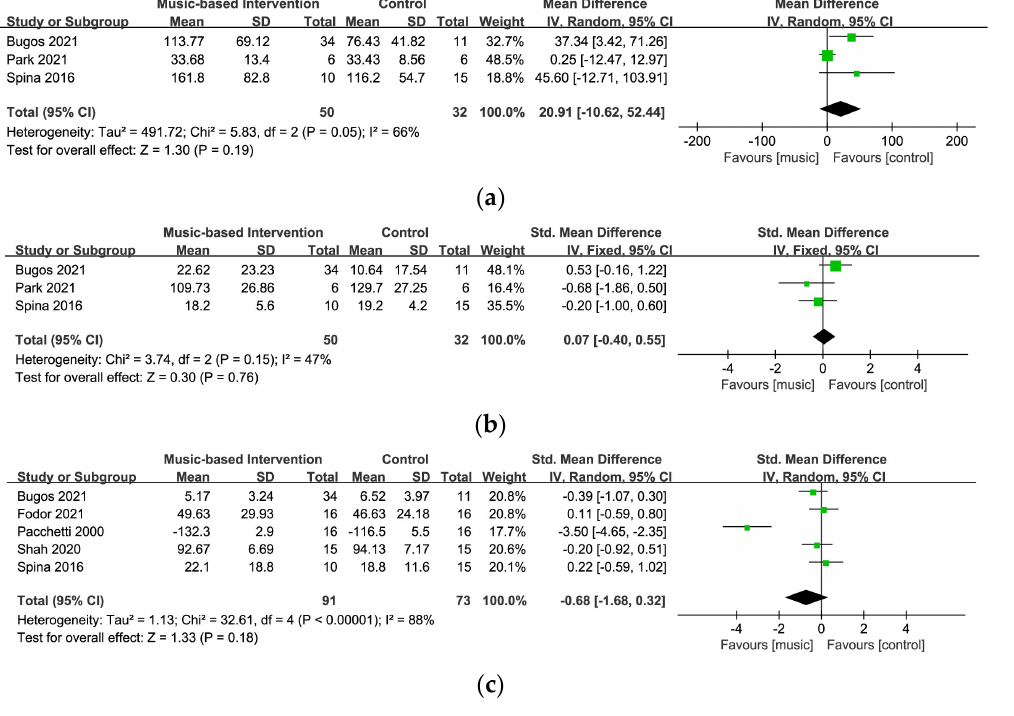
Figure 5. Forest plots for ( a ) cognitive flexibility [29,30,57], ( b ) inhibition [29,30,57], and ( c ) quality of life